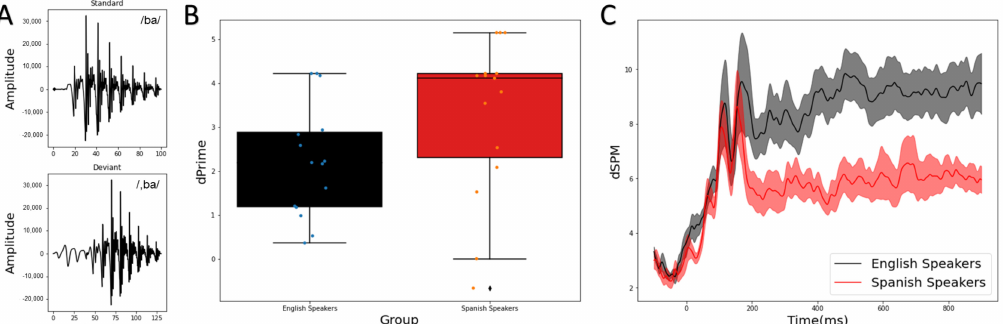
Figure 1. ( A ) Waveforms for the standard stimulus ( top ) and the deviant stimulus ( bottom ). ( B ) Behavioral sensitivity (d’) is different between the two groups, with Spanish speakers exhibiting higher d’ overall as this contrast is native to them. ( C ) Global MMR is different between the two groups with Spanish speakers exhibiting reduced MMR after 200